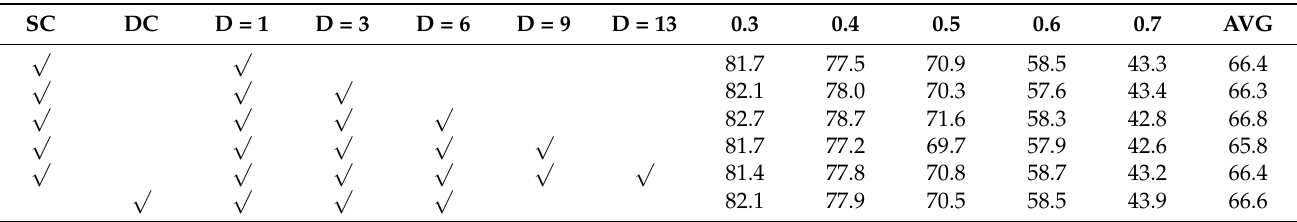
Table 5. Ablation Study (impact of CC module). Comparing the effect of chunk convolutions with different dilation rates (D). DC represents dilated convolution, SC represents standard convolution, measured by mAP@tIoU at different thresholds and the average mAP (mAP@avg) [0.3:0.1:0.7]. √ indicate the selected dilation